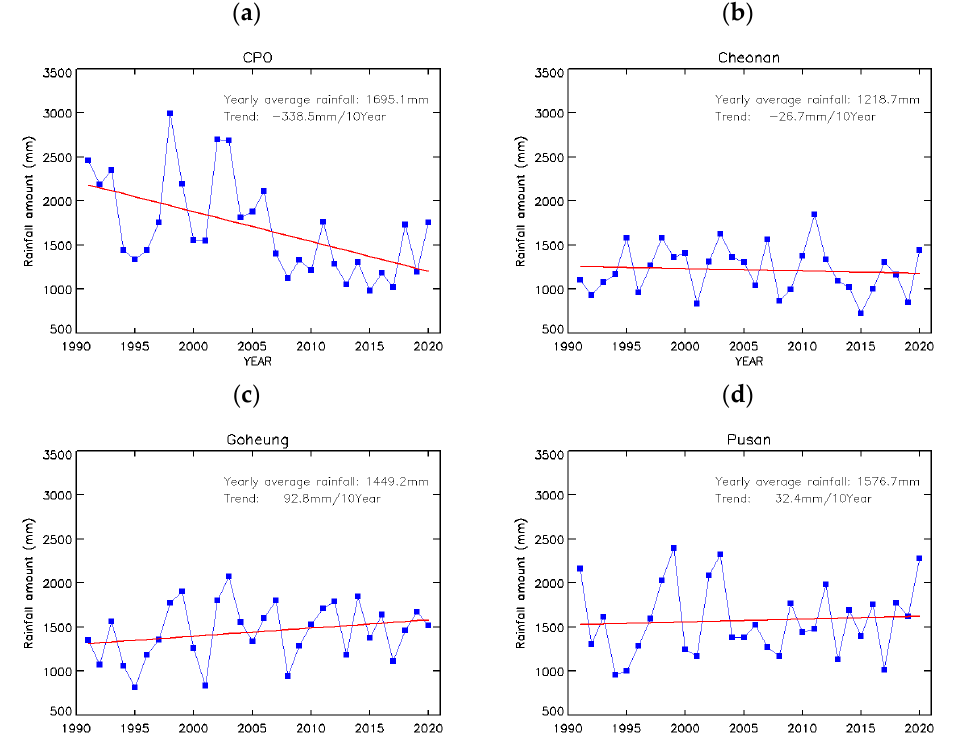
Figure 2. The time series of annual rainfall (blue) and the trend (red) for 30 years at ( a ) CPO, ( b ) JIN, ( c ) BOS, and ( d ) BUS site. Cheonan is the nearest official station to JIN, Goheung is the nearest site to BOS, and Pusan is the nearest site to BUS.